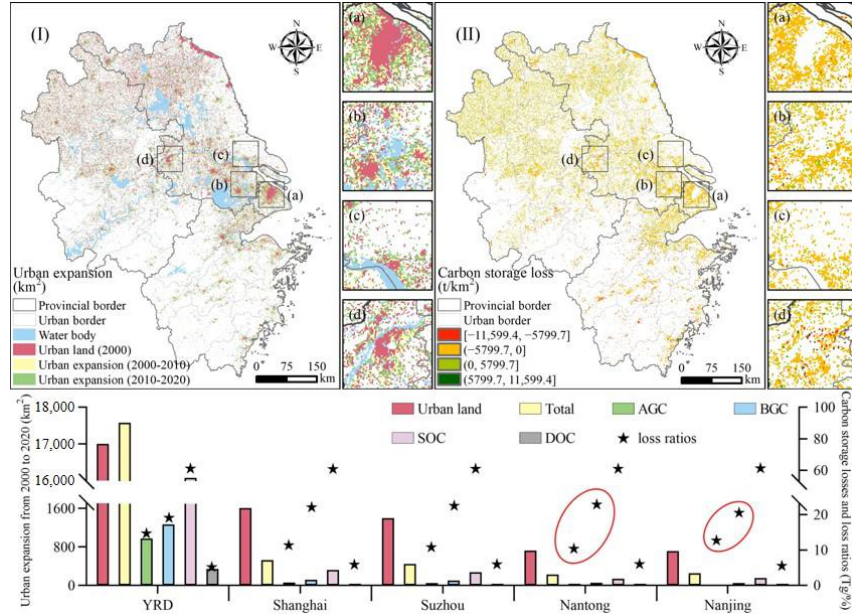
Figure 3. Urban expansion in the YRD and the resulting loss of TCS from 2000 to 2020: ( Ⅰ ) urban expansion, ( Ⅱ ) loss of TCS, ( a ) Shanghai, ( b ) Suzhou, ( c ) Nantong, ( d ) Nanjing. Urban expansion leads to increasing TCS losses , most of which occur in soil (Figure 3II). From 2000 to 2020, the YRD lost 90.189 Tg of TCS. Among the four carbon pools, SOC decreased by 55.13 Tg, accounting for 61.127% of TCS loss, while AGC, BGC, and DOC decreased by 13.208, 17.216, and 4.635 Tg, accounting for 14.645, 19.089, and 5.139% of